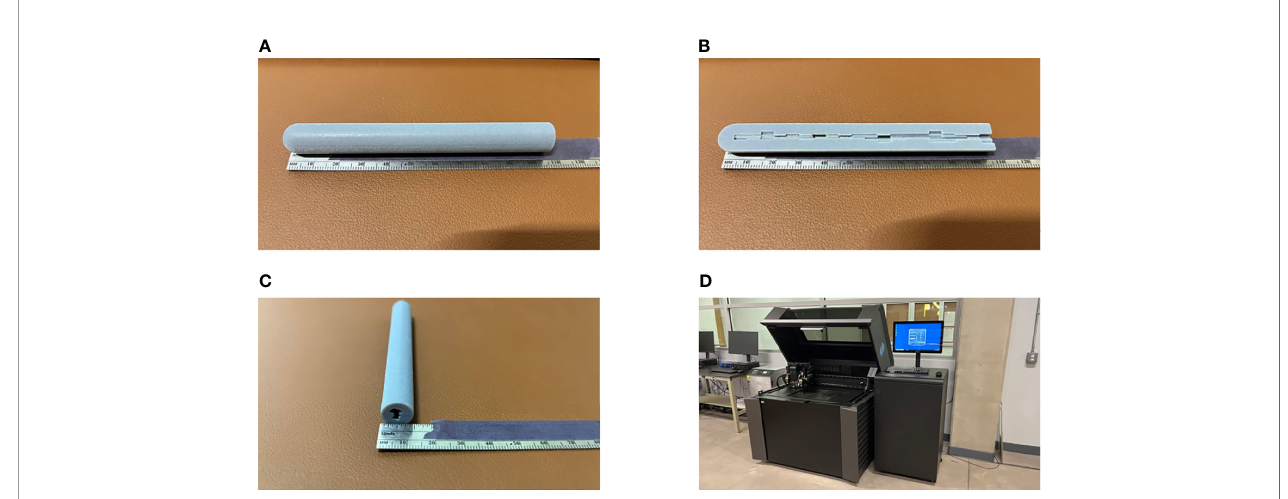
FIGURE 11 | A prototype of our proposed IMBT printed by a 3D printer. (A – C) The actual printing that has a diameter of 1.2 cm and 10 cm long for illustrative purpose. (A, C) The whole piece of the IMBT tandem printed. (B) The half-cut of the printed IMBT tandem to visualize the inner shape. (D) The PolyJet print that we used for this study due to the fi ne resolution (30 µm) and the color availability (Pantheon 444C). It takes two hours to print and